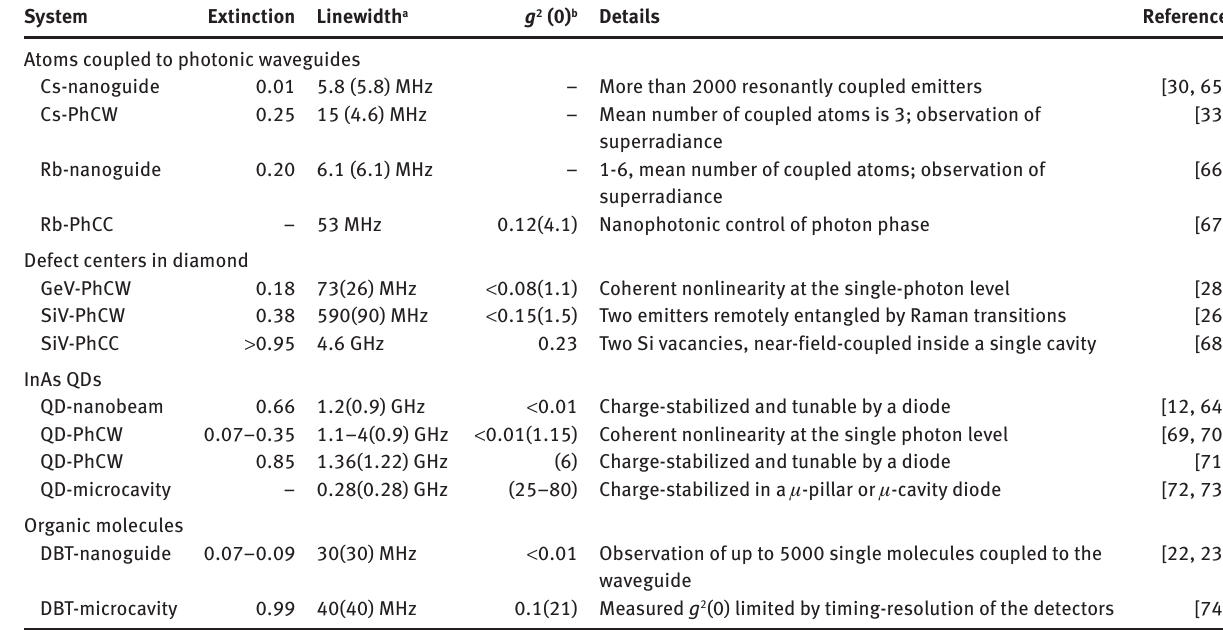
Table 1: State-of-the-art coherent light-matter interactions with solid-state quantum emitters coupled to nanophotonic waveguides. System Extinction Linewidth